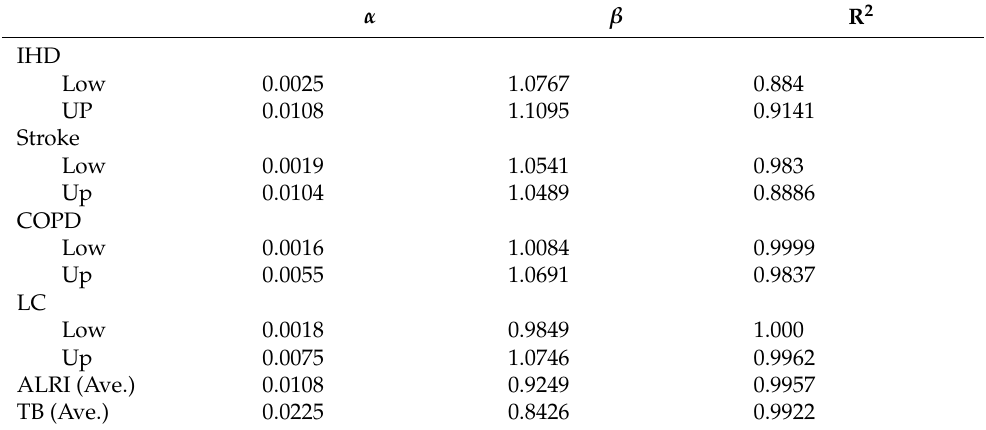
Table 3. Estimated RR linear equation (95% CI) (Estimated by the